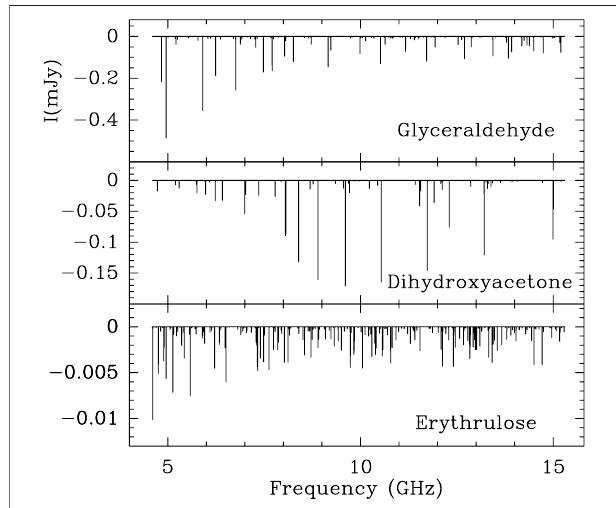
FIGURE 1 | Predicted absorption spectra of the C 3 and C 4 sugars glyceraldehyde, dihydroxyacetone and erythrulose obtained with the SLIM tool of the MADCUBA package considering the physical conditions of the G+0.693 molecular cloud (T ex = 10K, linewidths of Δ v = 20 km s − 1 and extendedemissionacrossthebeam)andabackgroundsourcesimilartotheL sourceintheSgrB2Nmolecularcomplex(measured fl uxof~300 mJywithina beamof1 ″ at10 GHz).Theassumedcolumndensitiesforglyceraldehydeand dihydroxyacetone are 10 13 cm − 2 and 6.8× 10 12 cm − 2 , respectively, while for erythrulose we assume a column density one order of magnitude lower than that of glyceraldehyde (of 10 12 cm − 2 ; see Section 3.1